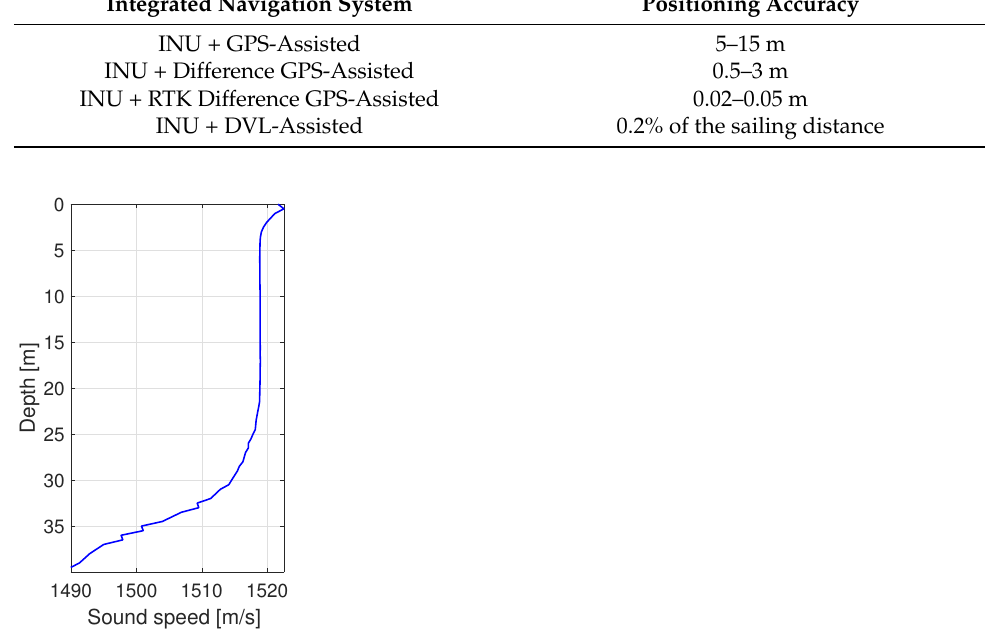
Figure 8. The sound speed profile measured by the RBRconcerto CTD at the study area in the northern South China